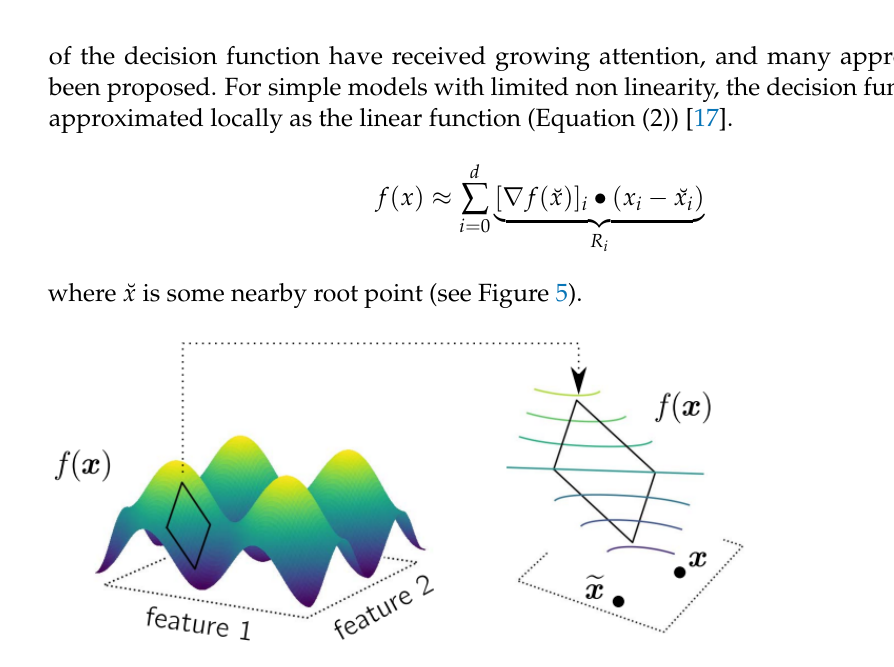
Figure 5. Nonlinear function of the input features, which produces some prediction. The function can be approximated locally as a linear